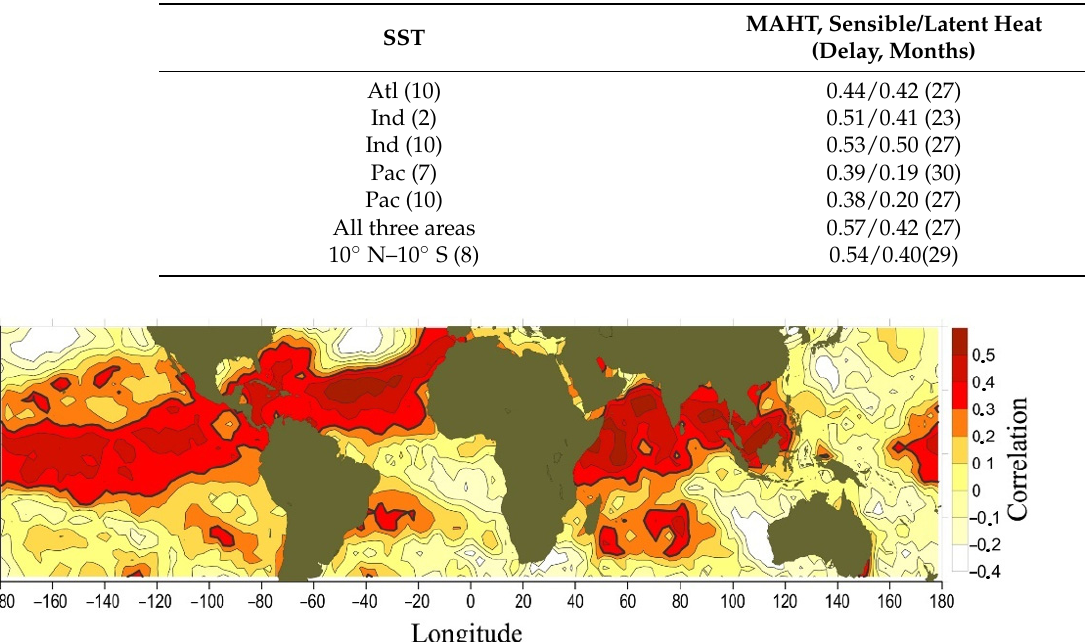
Table 1. Correlation between mean monthly SST in low-latitudinal regions of the North Atlantic (Atl), Indian (Ind), and the Pacific (Pac) oceans in the month indicated in brackets and the winter meridional atmospheric transport (MAHT) for 1982–2014 (in brackets—the MAHT delay in months. The significant coefficient correlation is more than 0.34 (95% confidence)).